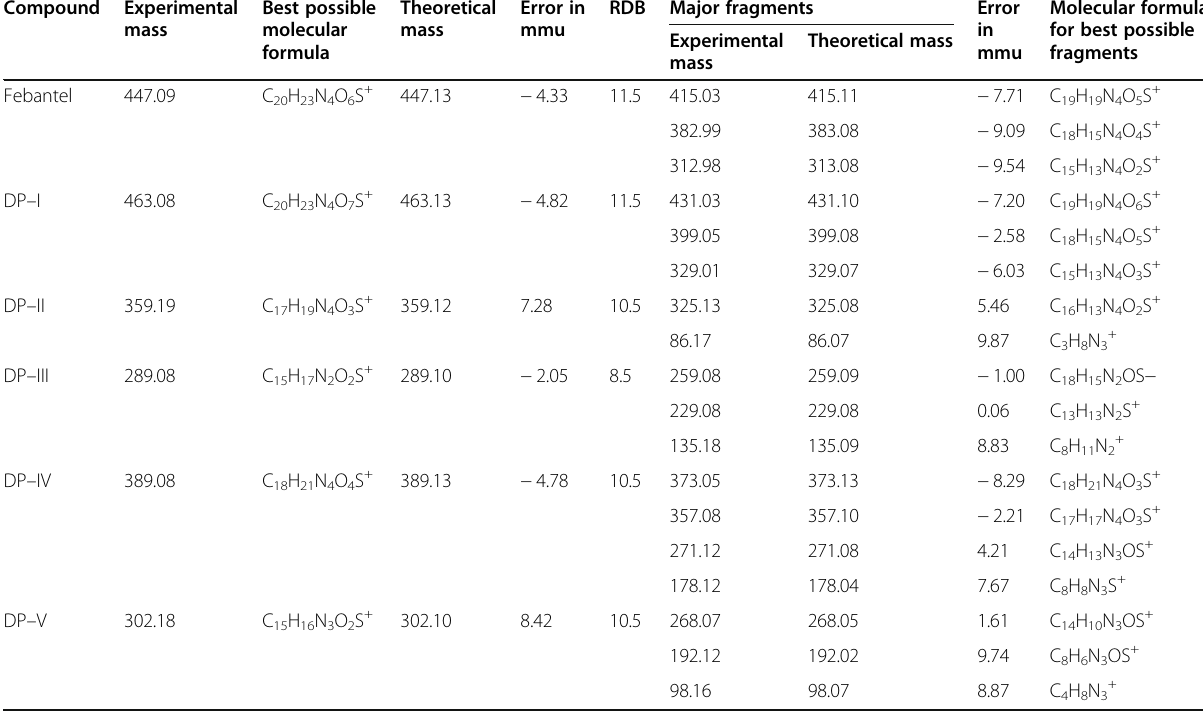
Molecular formula in for best possible mmu